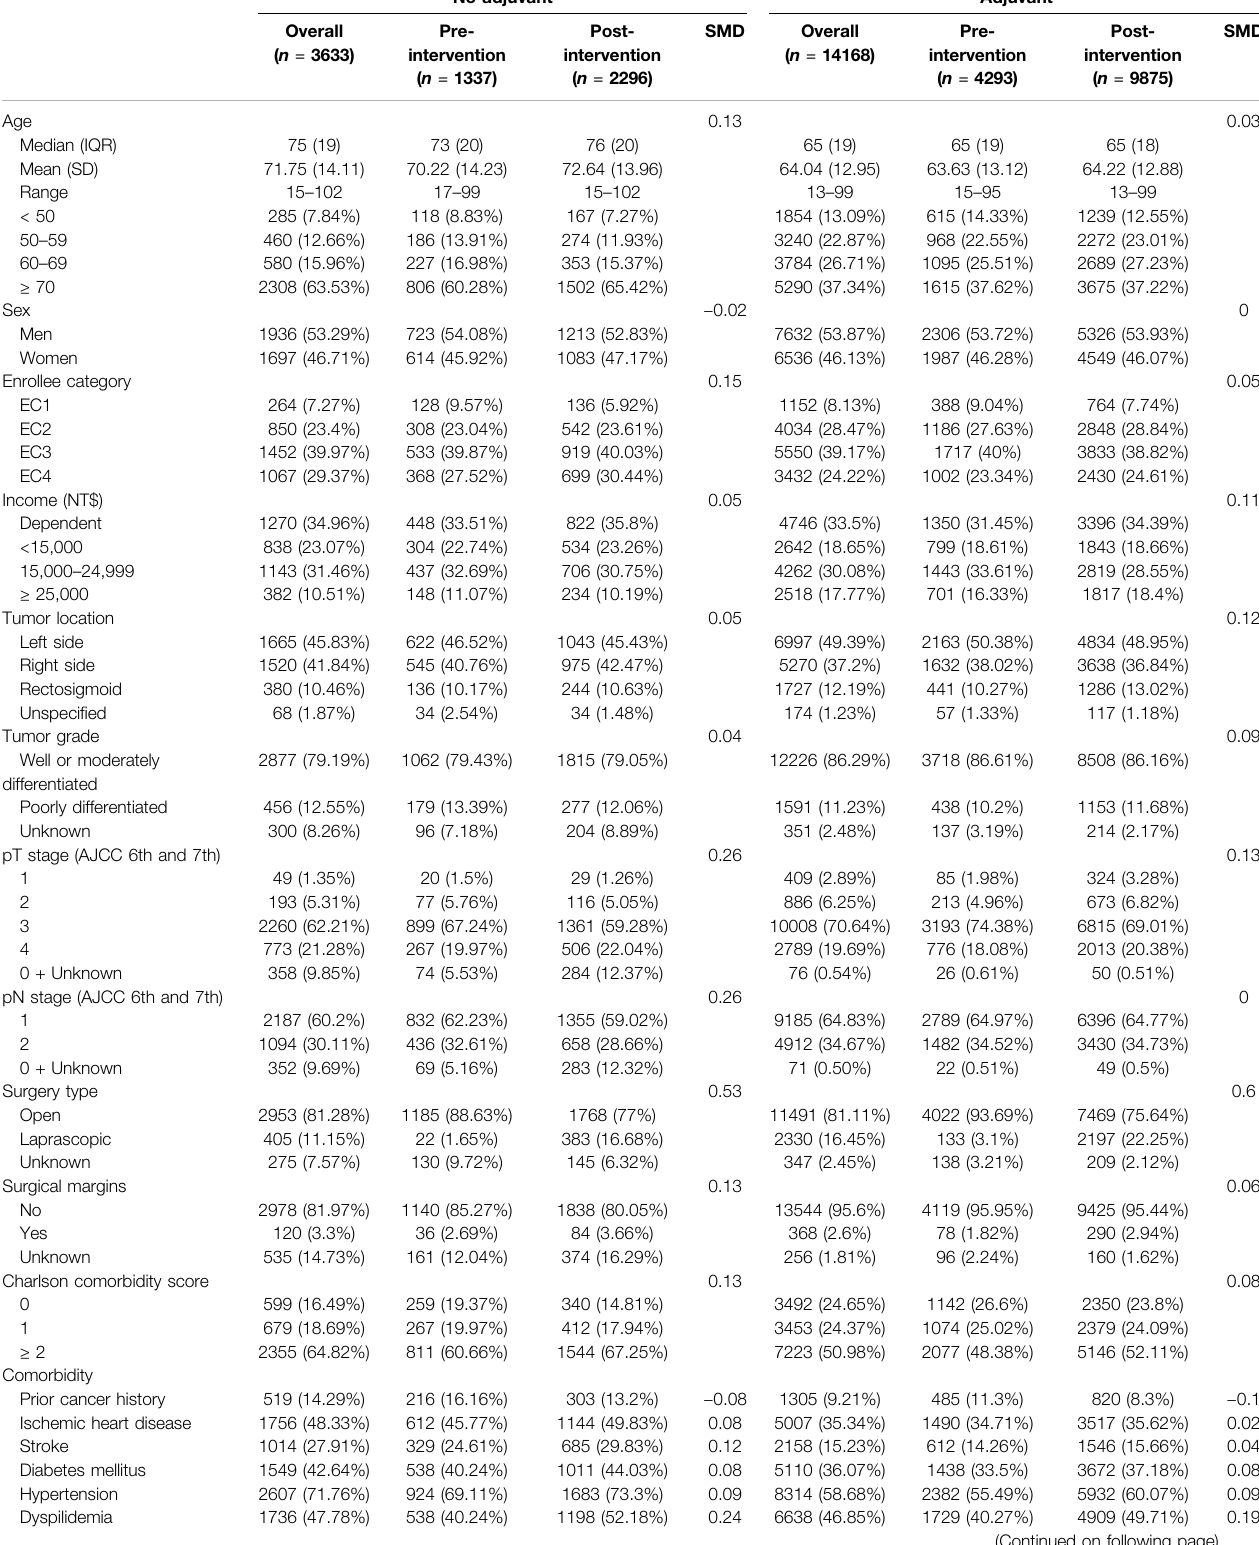
TABLE 1 | Characteristics of demographic, tumor, comorbidity, medication use among patients with stage III colon cancer before (2004 – 2008) and after (2009 – 2014) introduction of oxaliplatin, before